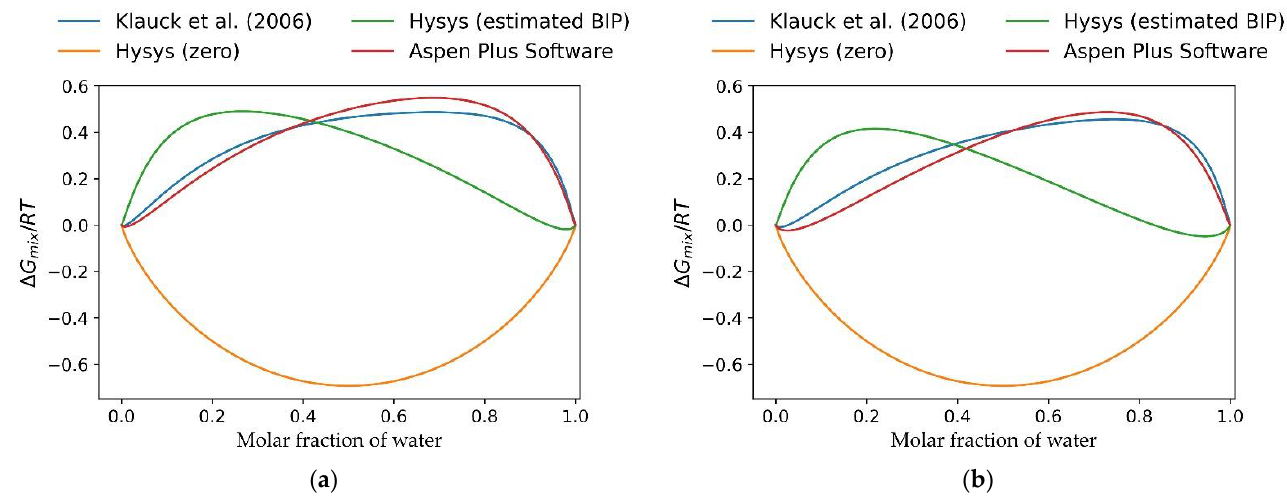
Figure 4. Gibbs Free Energy of Mixing for a n-Octane/Water System, at Various Water Molar Fractions and Two Thermal Levels: ( a ) 70 ◦ C and ( b ) 100 ◦ C. Table 4. Predicted Mutual Solubilities for Water(1)/n-Octane(2) Blends at 70 ◦ C and 100 ◦ C in liquid phase molar